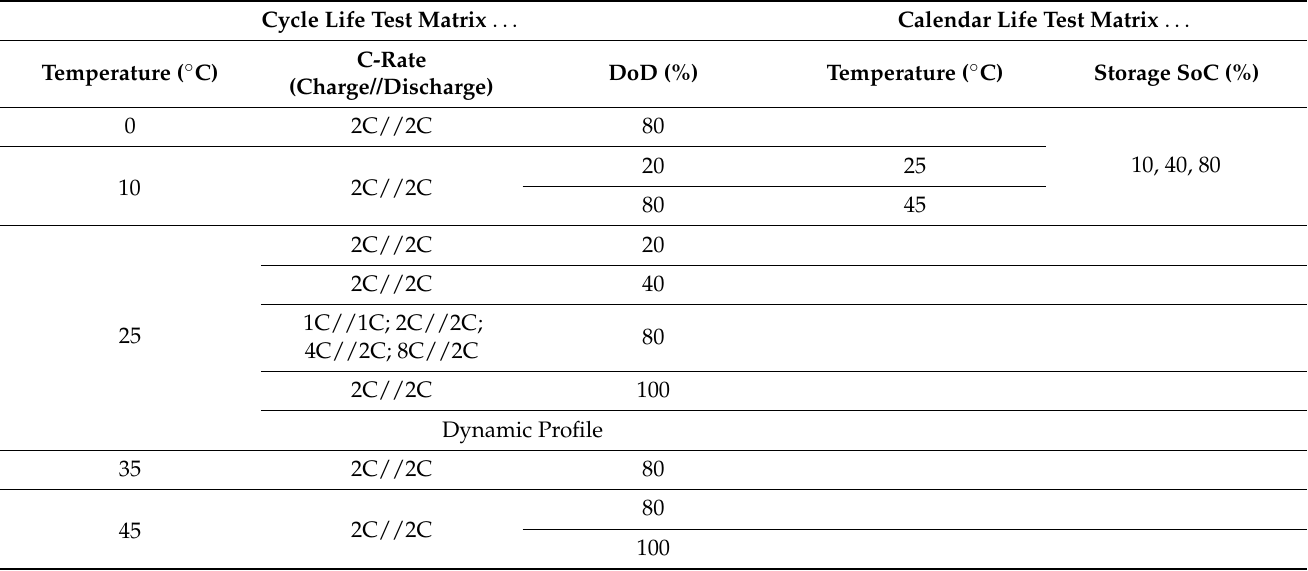
Table 1. Operating conditions of the aging study. Cycle Life Test Matrix . . . Calendar Life Test Matrix . .